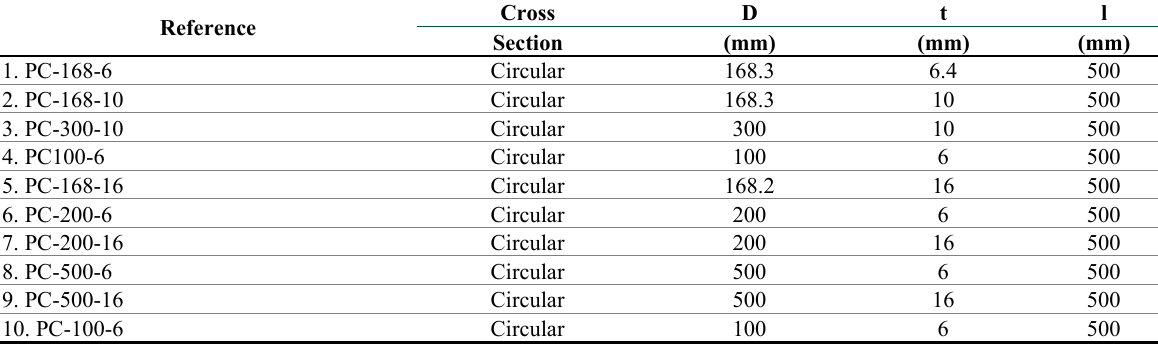
Table 2. Specimens for the model with heat transfer analysis.